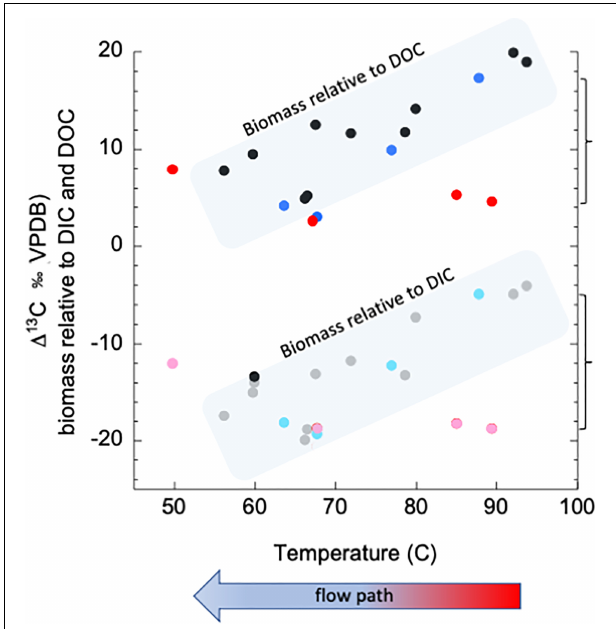
FIGURE 1 | Isotopic composition of carbon in biomass in sediments at “Bison Pool,” Yellowstone National Park, relative to that of dissolved inorganic and organic carbon. Figure shows samples with flow down the outflow channel, with the hottest samples near the source at the right end of the X -axis. “Historic,” multi year values are in black and gray points, within blue fields. Values immediately following the precipitation event are in red and pink. Values representing recovery after 8 days are in shades of blue. Methods can be found in Supplementary Material